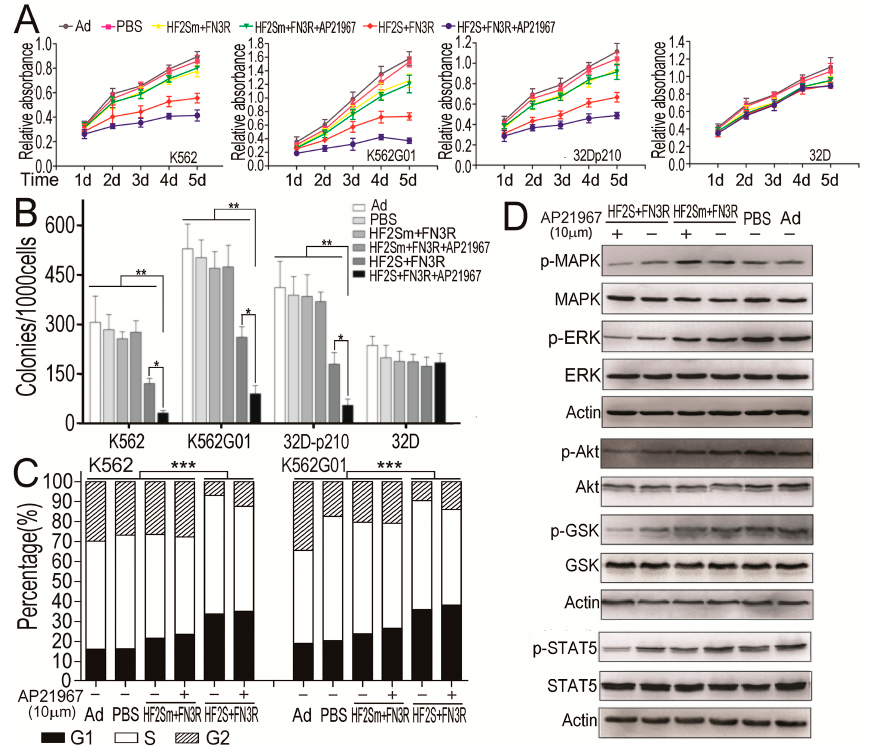
Figure 4. HF2S inhibited CML cell proliferation through mitogen-activated protein kinase